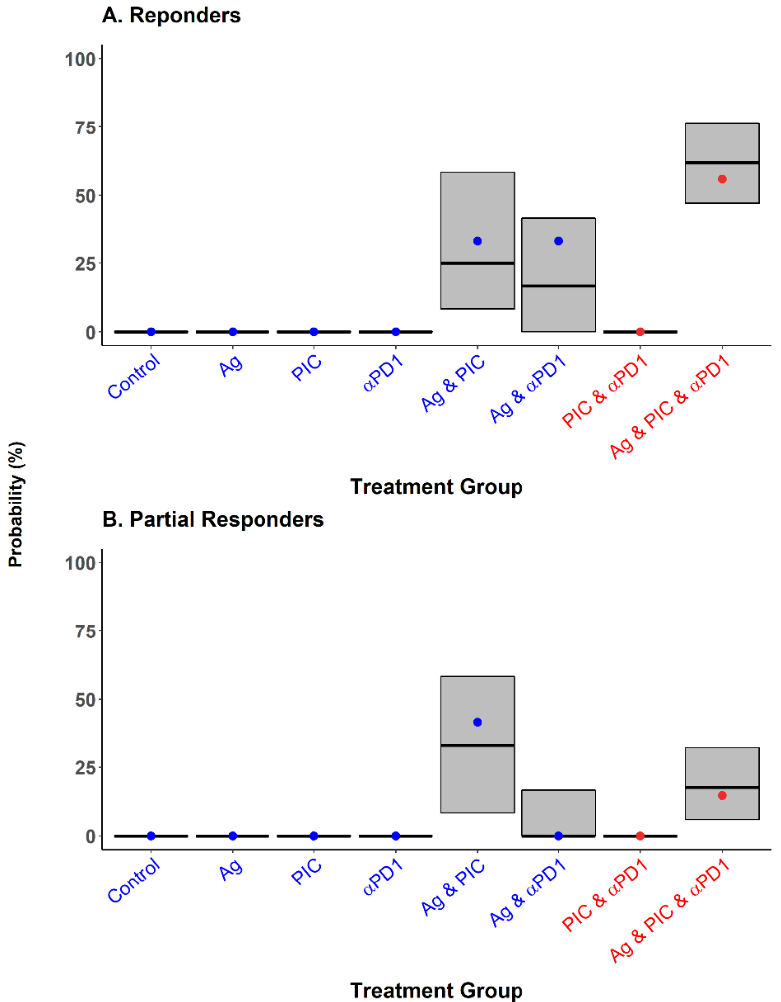
Figure 5. Simulation-based model diagnostics. The percentage of cure ( A ) and partial response ( B ) calculated over 1000 simulated studies is presented and compared with the percentage calculated from the raw data. Grey areas represent 90% prediction interval of the simulated data, with the horizontal line in black showing the median of the distribution. Dots correspond to the percentages obtained from the observed data (blue for the treatment groups used for model development and red for the triple-therapy group used for external validation).